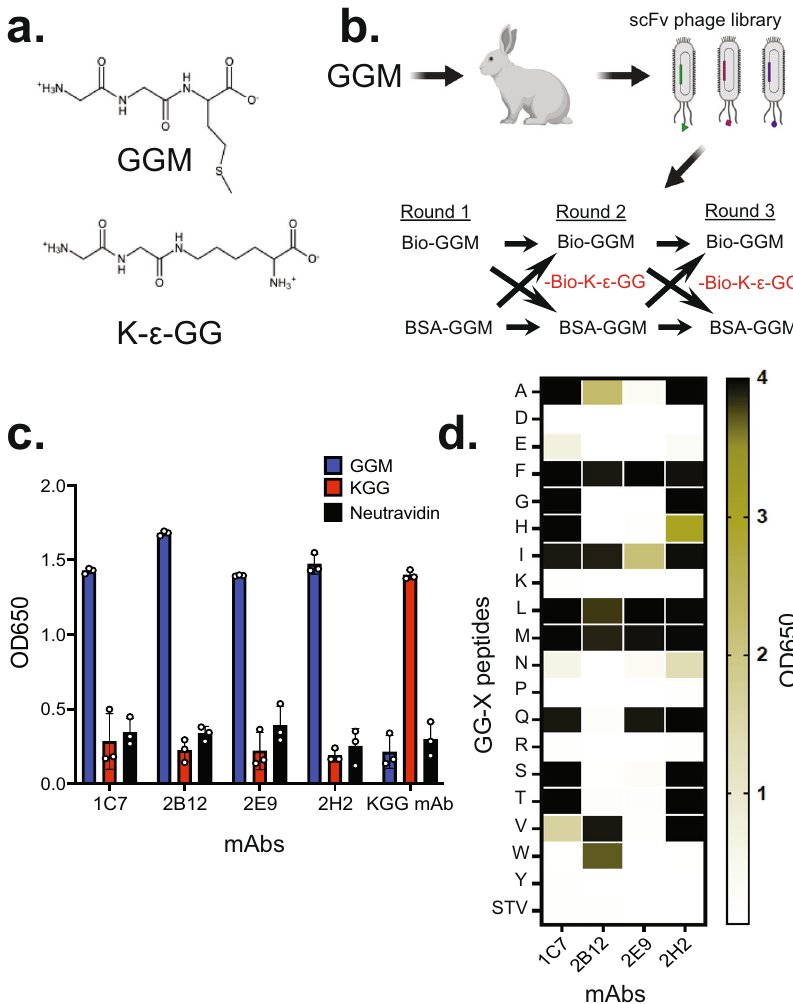
Fig. 1 Discovery and characterization of anti-GGX mAbs. a The chemical structure of GGM and K- ε -GG peptides highlights the high similarity between both peptides. b Schematic of the immunization and phage panning strategy used to discover the anti-GGX mAbs. Biotinylated (Bio-GGM) and BSA conjugated (BSA-GGM) were used for positive selections and a biotinylated K- ε -GG (red, Bio K- ε -GG) was used for negative selections. c ELISA characterization of the four anti-GGX mAbs and anti-K- ε -GG mAb con fi rms the GGM speci fi city of the antibodies. Binding to the GGM peptide is shown in blue, K- ε -GG peptide in red, and neutravidin in black. Results are representative of biological replicates ( n = 3). Data are presented as mean ± SD. d ELISA characterization of anti-GGX mAbs against GGX peptides, in which X represents all twenty amino acids except for cysteine, shows degenerate recognition at the X position. The darker shading corresponds to the better binding. STV is the streptavidin control. Results are representative of biological replicates ( n = 3). Data are presented as mean ± SD. Source data are provided as a Source Data fi